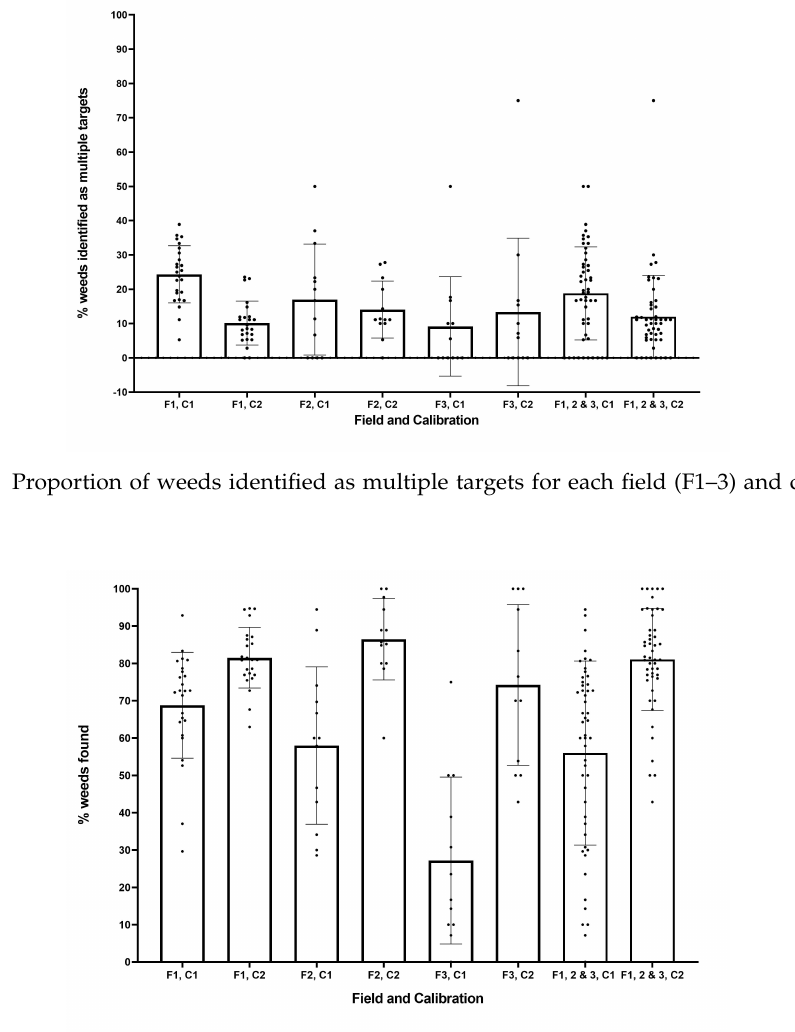
Figure 12. Proportion of weeds identified for each field (F1–3) and calibration (C1, C2).